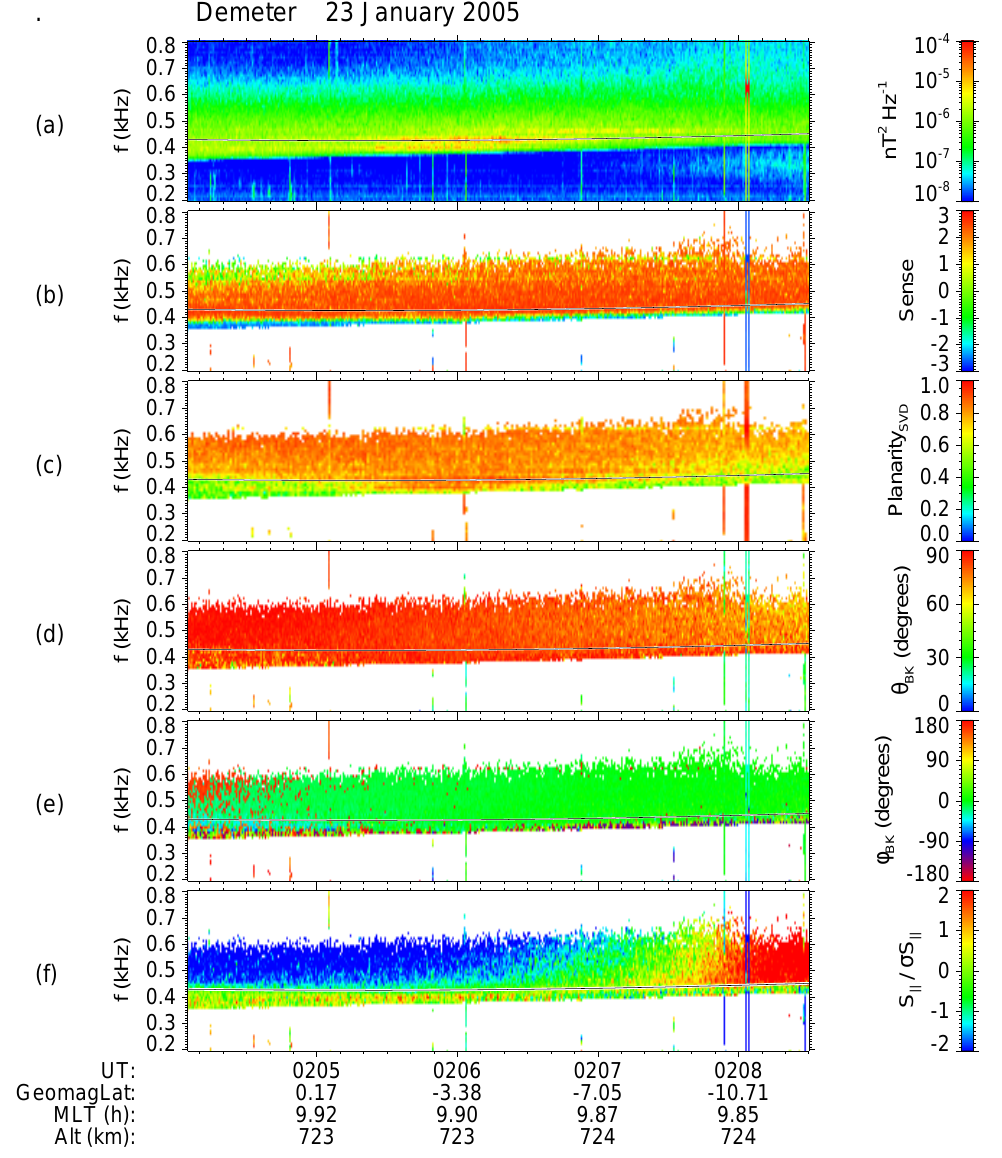
Fig. 11. Same presentation as in Fig. 9 but for the event